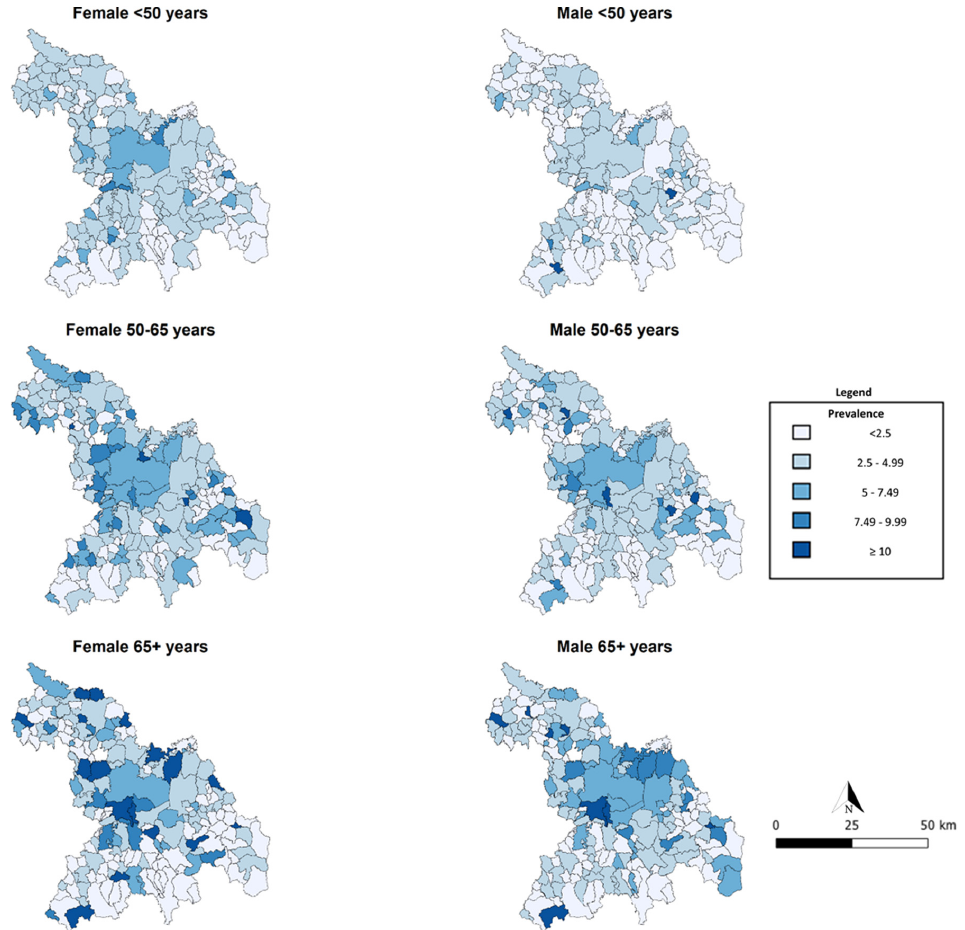
Figure 4. Choropleth maps of Alessandria LHA, divided by gender and age. Colors represent the percentage of positive NP swabs divided by the population stratified by groups.